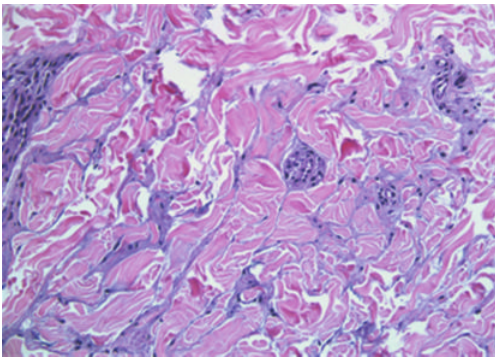
Figure 3: High power (40X) increase in dermal